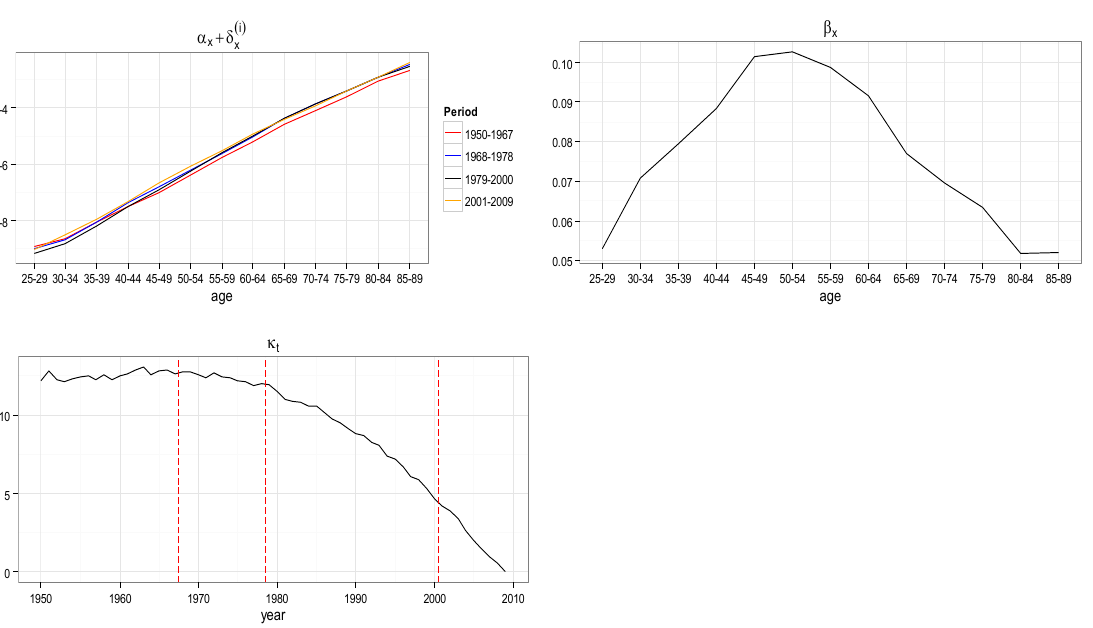
Figure 3. Adjusted mortality index, Cancer and Circulatory System Illness, UK Male population, age groups 40–45, 50–54, 60–64, 70–74.